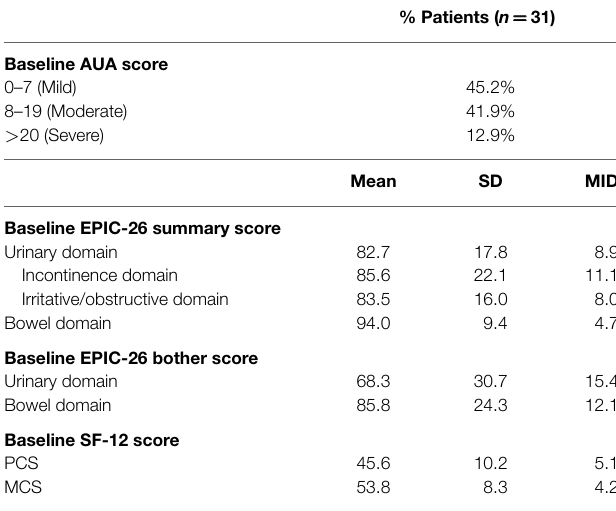
TABLE 2 | Pre-treatment quality of life (QOL) scores